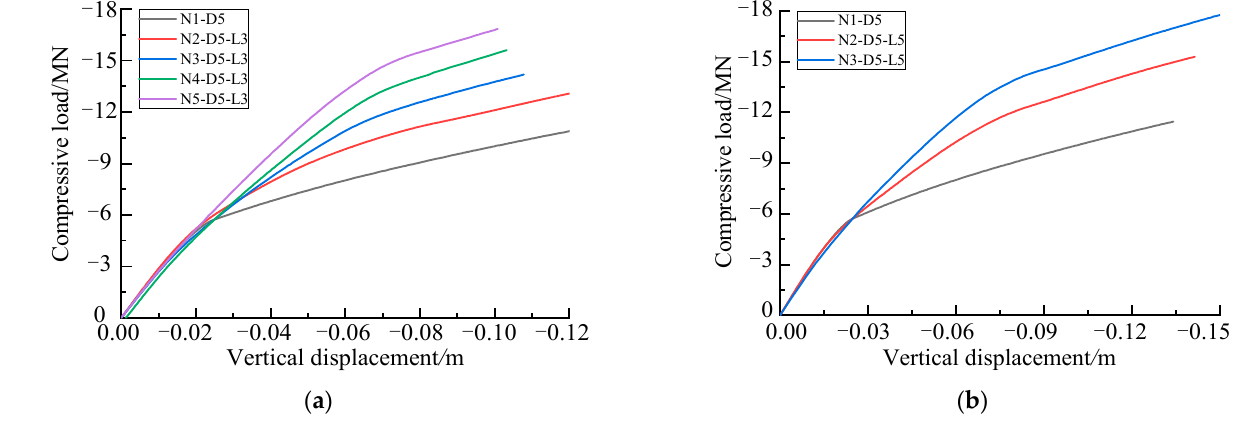
Figure 30. Compressive load-displacement curves of multi-blade helical pile. ( a ) D /d = 2, l/ D = 0.6, n = 1–5; ( b ) D / d = 2, l/ D = 1, n = 1–3. Table 10. Compression efficiency coefficient of multi-blade helical